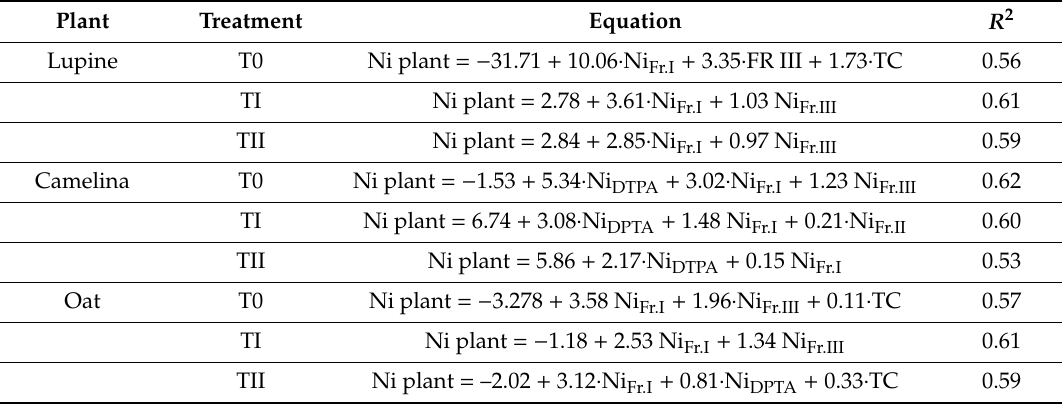
Table 3. Multiple regression equations for the relations between Ni content in plants and in Ni forms for soil